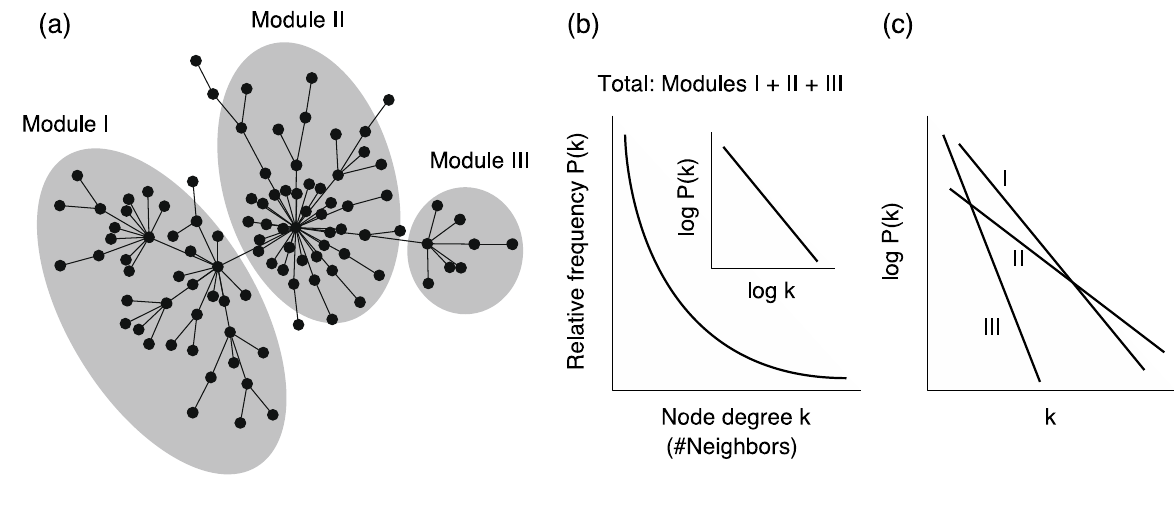
Figure 5. (a) Schematic diagram of heterogeneous connectivity in metabolic networks. (b) The node degrees in whole networks follow a power-law distribution. Note that the inset graph is a double logarithmic plot. (c) On the other hand, the node degree in each module (sub-network) follows an exponential distribution, and the distributions are different between the modules. Note the single logarithmic